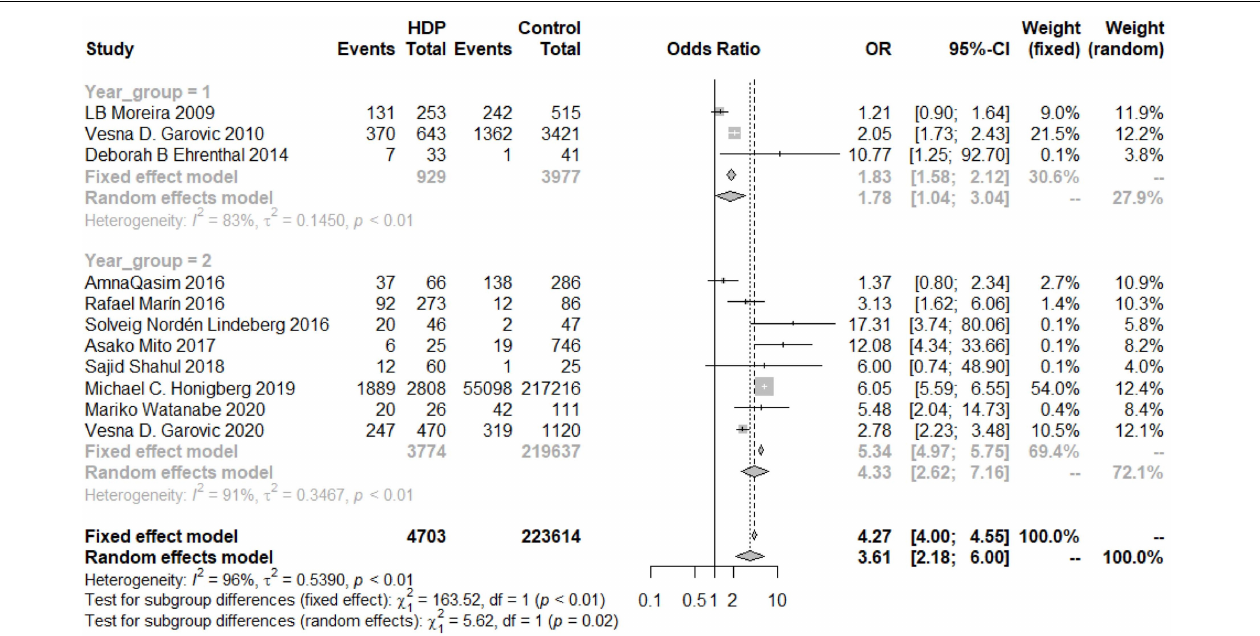
FIGURE 7 | Subgroup analysis by publication year of the risk of developing chronic hypertension in the HDP group (Group 1 = years < 2016, Group 2 = years ≥ 2016).